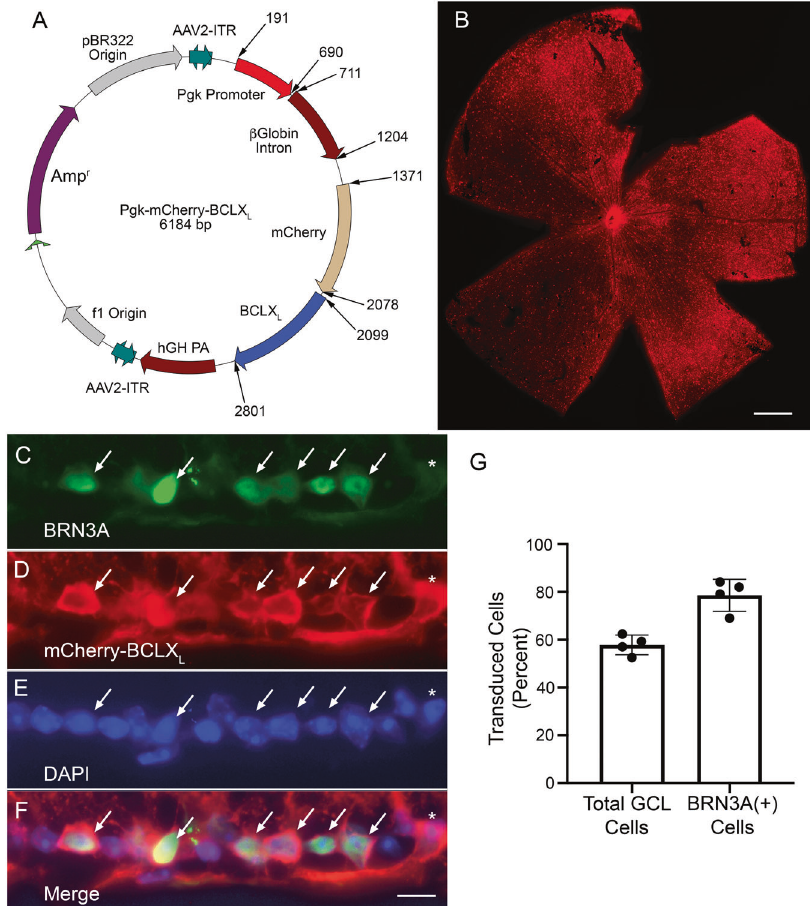
Fig. 2 The intraretinal expression pattern of mCherry-BCLX L following AAV2-Pgk-mCherry-BclXL transduction. A A map showing the plasmid that was packaged into AAV2-Pgk-mCherry-BclX L . B A retinal whole-mount preparation, 4 weeks after intravitreal injection, showing wide-spread expression of the transgene across the retina. Scale bar = 450 µm. C – F Co-localization of BRN3A-positive cells that were transduced by